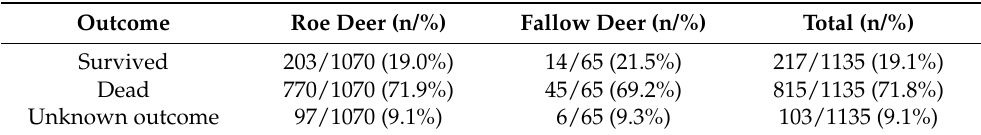
Table 4. Outcome expressed as the number and proportions (n/%) of roe deer and fallow deer, and total population.